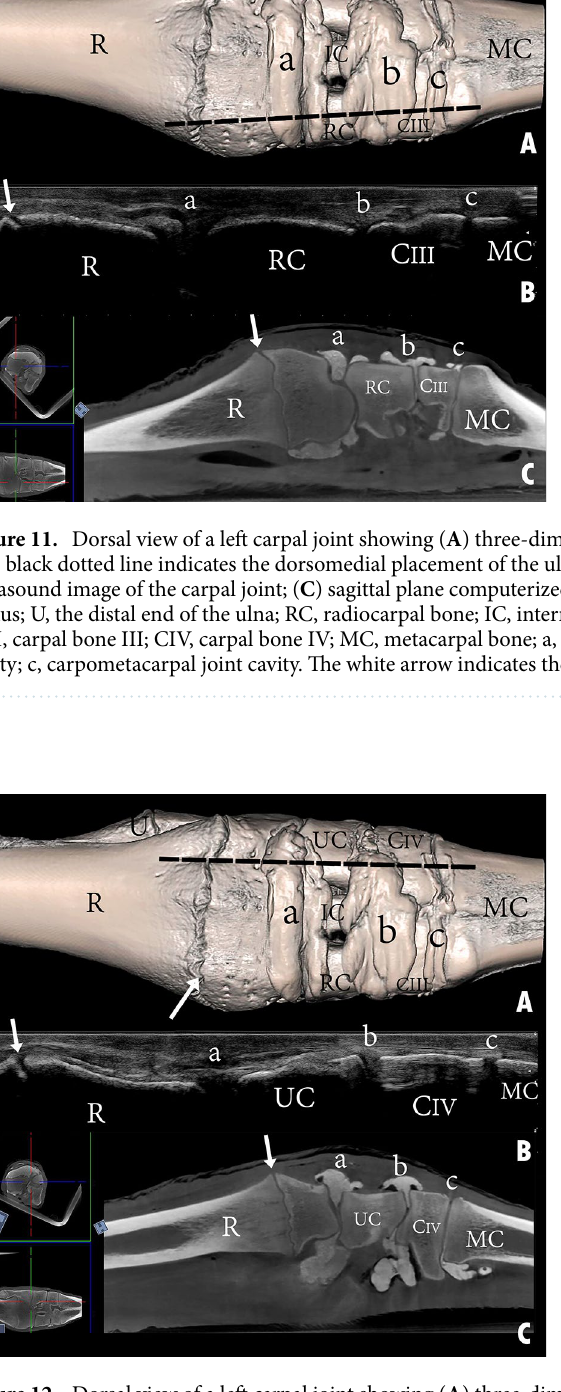
Figure 12. Dorsal view of a left carpal joint showing ( A ) three-dimensional reconstruction of the carpal joint (the black dotted line indicates the dorsolateral placement of the ultrasound probe); ( B ) longitudinal composed ultrasound image of the carpal joint; ( C ) sagittal plane computerized tomography image. R, the distal end of the radius; U, the distal end of the ulna; RC, radiocarpal bone; IC, intermediate carpal bone; UC, ulna carpal bone; CIII, carpal bone III; CIV, carpal bone IV; MC, metacarpal bone; a, radiocarpal joint cavity; b, intercarpal joint cavity; c, carpometacarpal joint cavity. The white arrow indicates the epiphysial